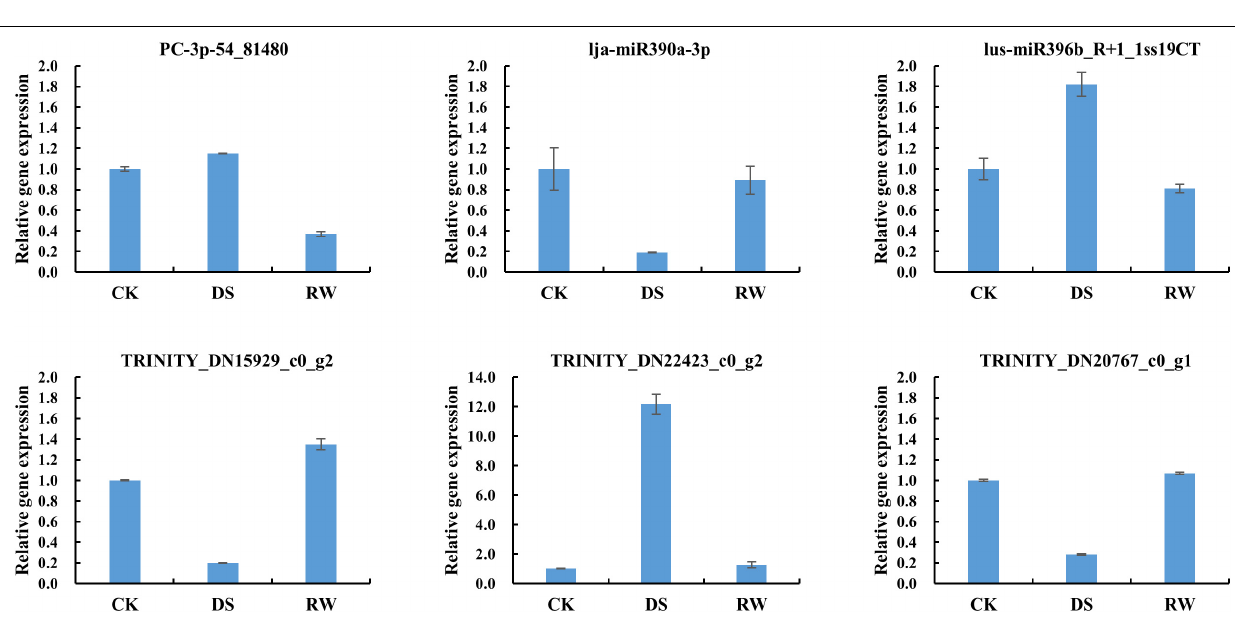
FIGURE 7 | Relative expression results of miRNAs and their target via qRT-PCR in M. ruthenica . GAPDH of alfalfa and mtr-U6 were used as an internal reference for mRNA and miRNAs, respectively. All qRT-PCR reactions were repeated three times for each sample. Error bars indicate the standard deviation of three biological